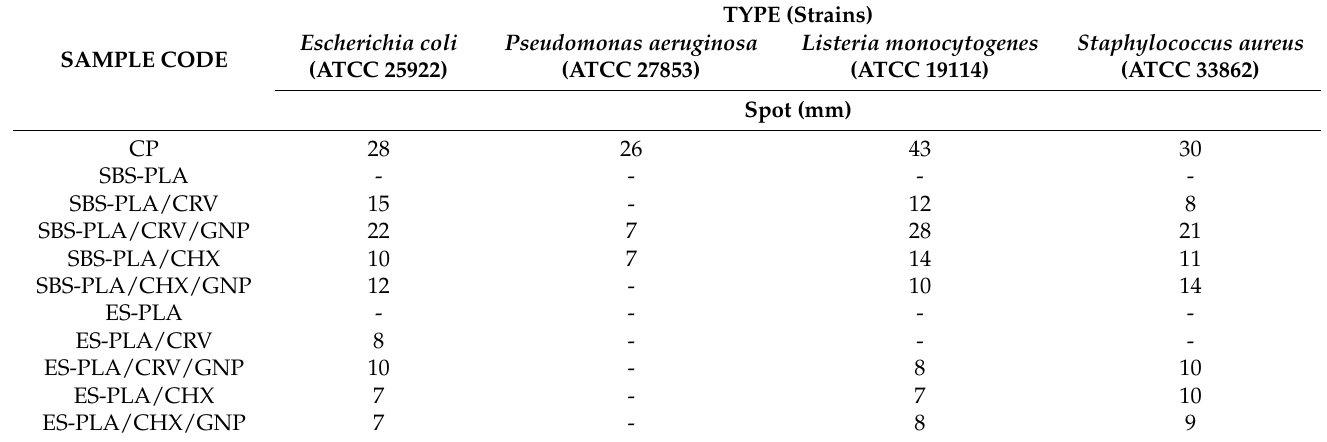
Table 3. Antimicrobial assay values of SBS and ES nanofibrous